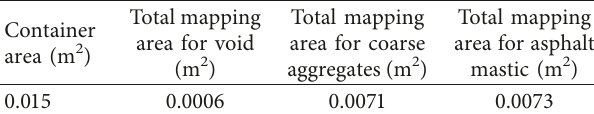
Table 6: Microparameters of selected constitutive models for particles and